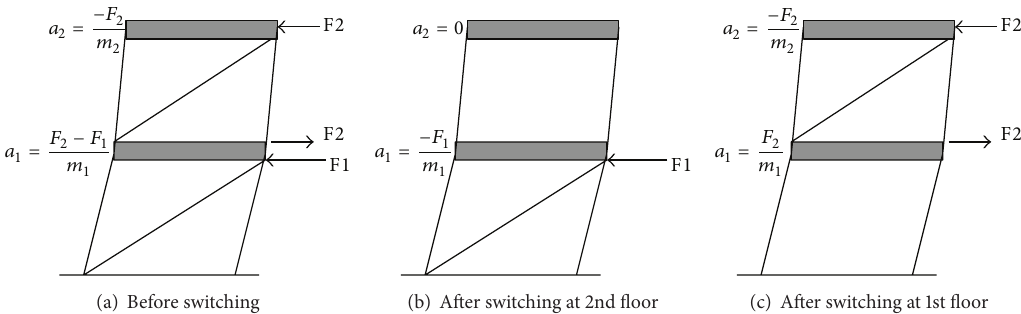
Figure 15: The reasons for inducing extra acceleration response of test structure with asynchronous switch.